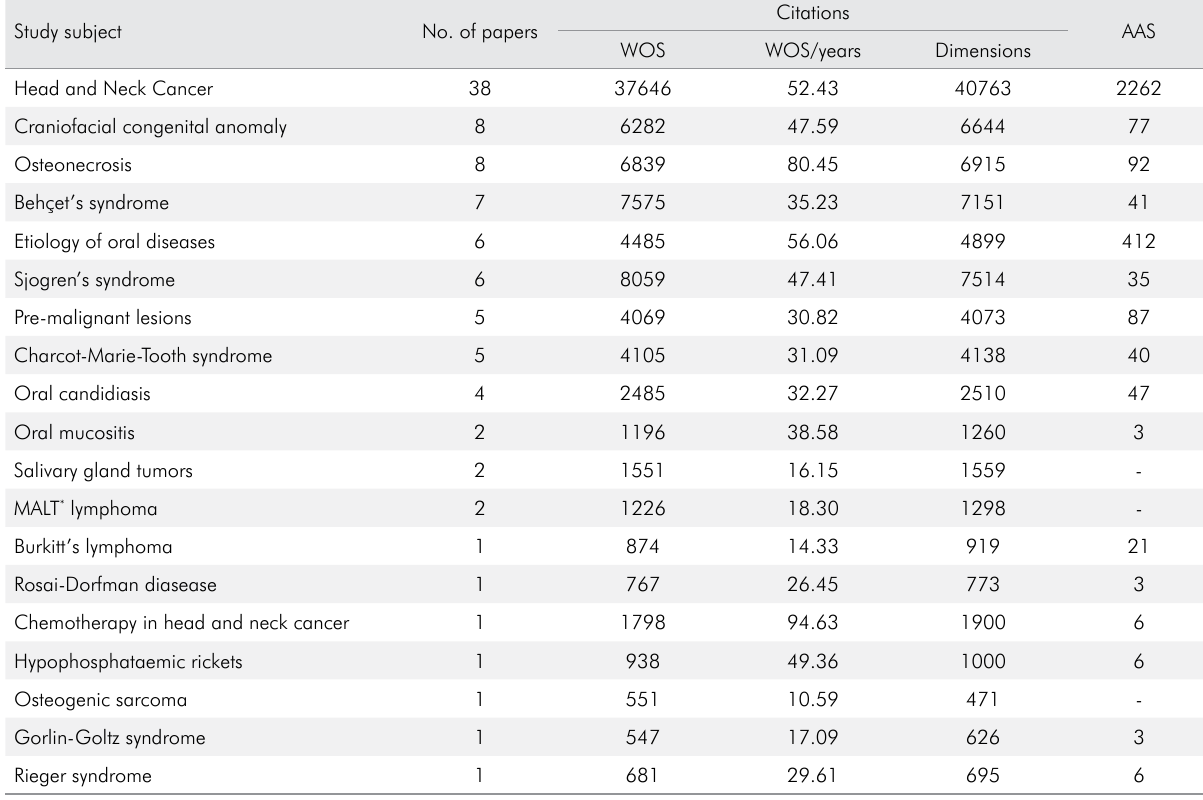
Table 4. Study subjects in the 100-top cited papers in pathology and oral medicine.